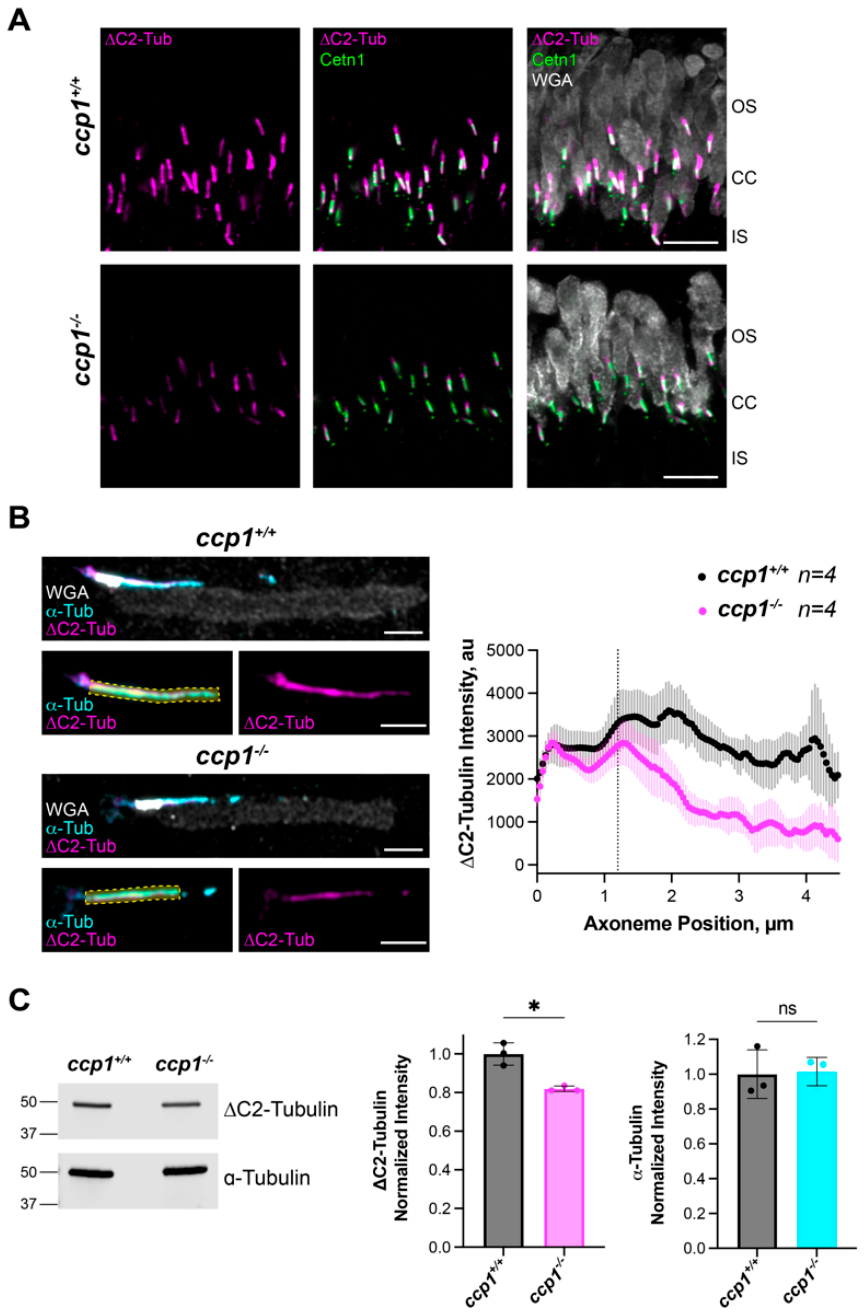
Figure 6. In ccp1 − / − mouse retinas, ∆ C2- α -tubulin staining is reduced distal to the connecting cilium in rod photoreceptor cells. ( A ) Representative images from P15 ccp1 +/+ and ccp1 − / − retinal cross-sections stained with anti-centrin1 (green), WGA (grey), and anti- ∆ C2- α -tubulin (magenta) antibodies. Scale bars, 5 µm. Abbreviations: outer segment (OS), connecting cilium (CC), and inner segment (IS). ( B ) Representative Airyscan images of isolated outer segments from P15 ccp1 +/+ and ccp1 − / − retinas stained with α -tubulin (cyan), WGA (gray), and anti- ∆ C2- α -tubulin (magenta) antibodies. Scale bar, 2 µ m. Averaged intensity plots shown to right. ( C ) Representative Western blot showing anti- ∆ C2- α -tubulin and anti- α -tubulin bands from ccp1 +/+ and ccp1 − / − retinal lysates. ∆ C2- α -tubulin and α -tubulin levels at P15 were quantified for 3 separate mice and normalized to wild-type ( ccp1 +/+ ) levels. * p = 0.0438; ns, not significant p = 0.8528.